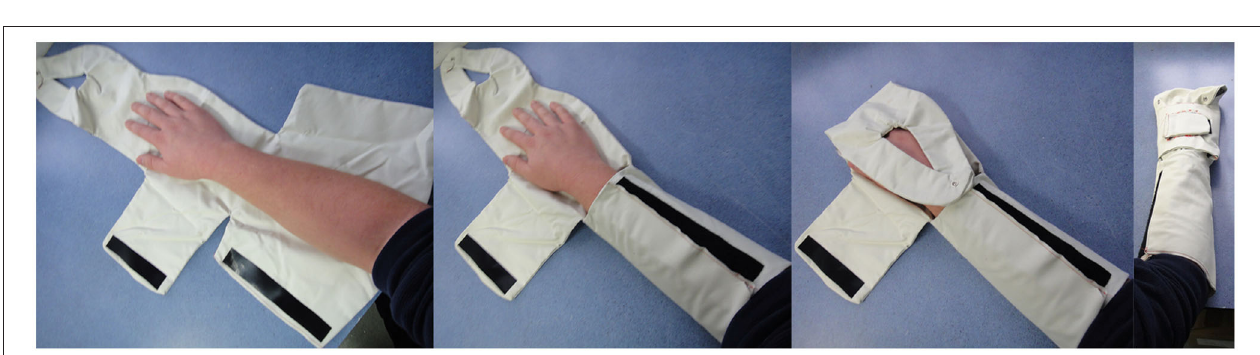
FIGURE 8 | Fabric “Sketch Modeling” prototypes for usability